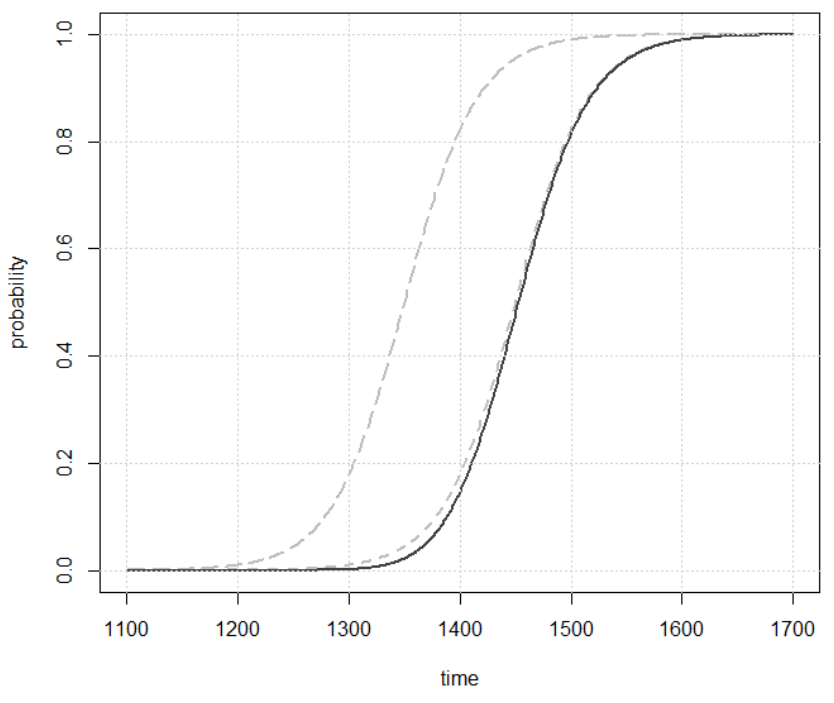
Figure 1. Spread of schwa-­‐loss (dark gray) as an interacting process of the loss of final (light gray, long dashes) and checked schwas (light gray, short dashes). The vertical axis measures the probability of a final /CəCə/ sequence being affected by the